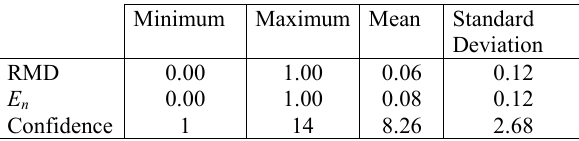
Table 2. Statistical information on the pixels uncertainty and confidence values obtained with the RMD, the normalized entropy ( E n ) and the classification confidence